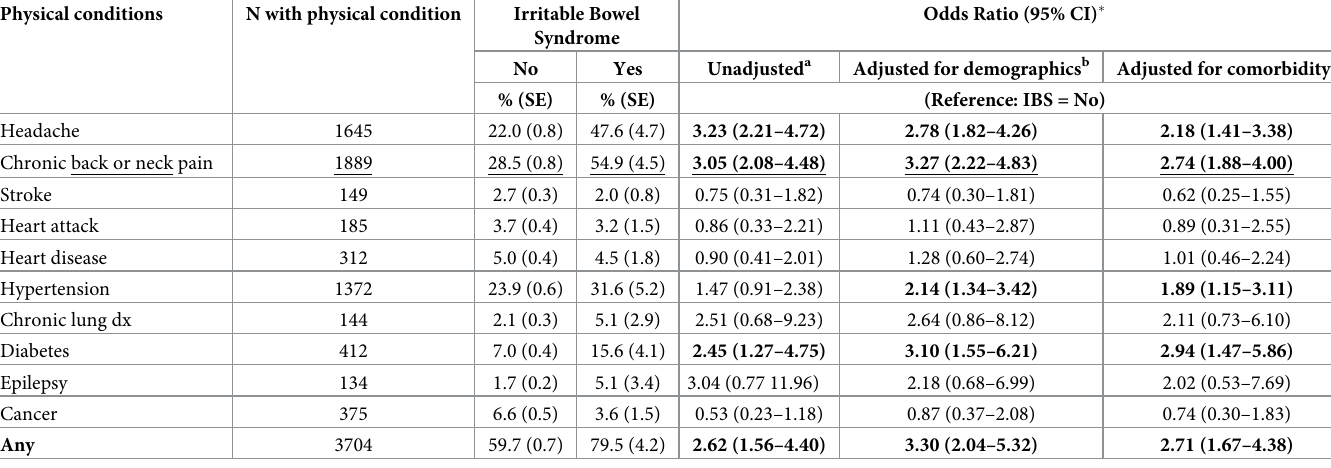
Table 3. Prevalence, unadjusted and adjusted risk of chronic medical conditions in the adult IBS cohort in the NCS-R Part II survey. Physical conditions